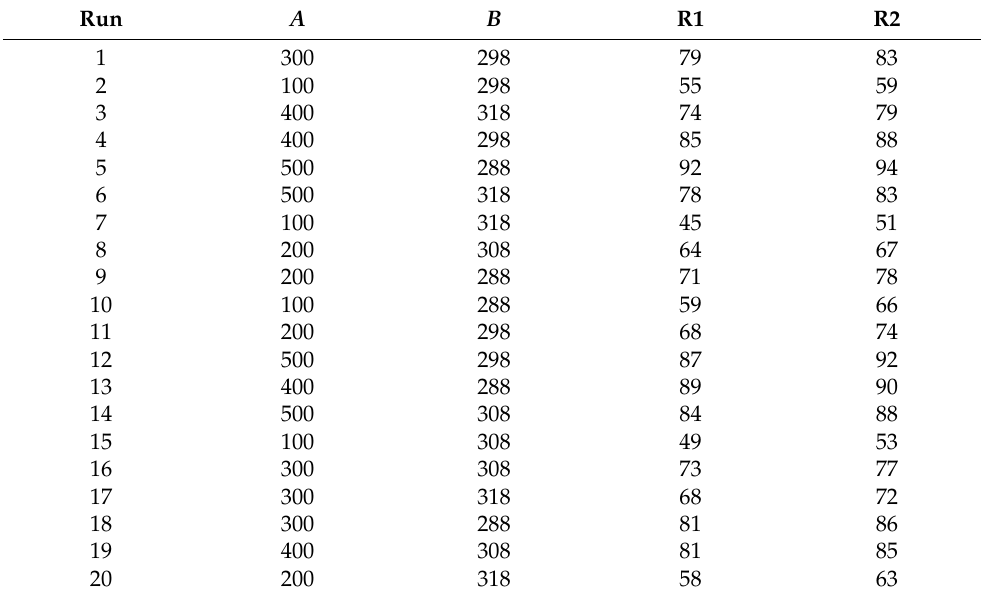
Table 8. Design matrix and RSM outcome for Al corrosion inhibition in 0.1 M NaOH medium by the examined compounds.